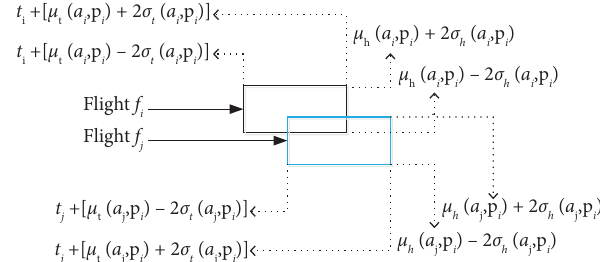
Figure 2: Schematic diagram of the interaction between fights.